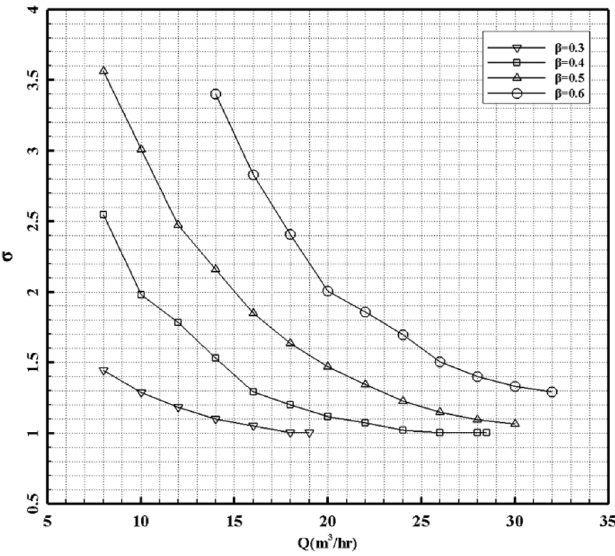
Fig. 6. Comparison of cavitation number variation for different ori fi ces.